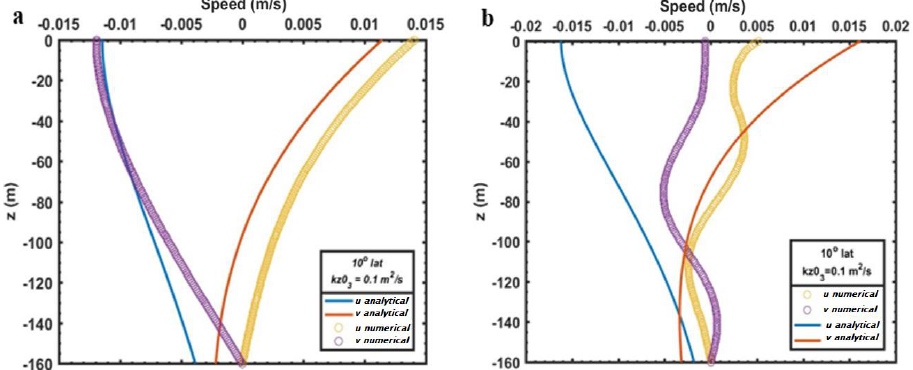
Figure 9. In ( a ), the analytical and numerical development of the classical Ekman model is observed; ( b ) shows the variation of velocity u and v with depth along the Ekman spiral considering the modified model, with k z0 constant in the surface water column and the modified model in which k z is variable.